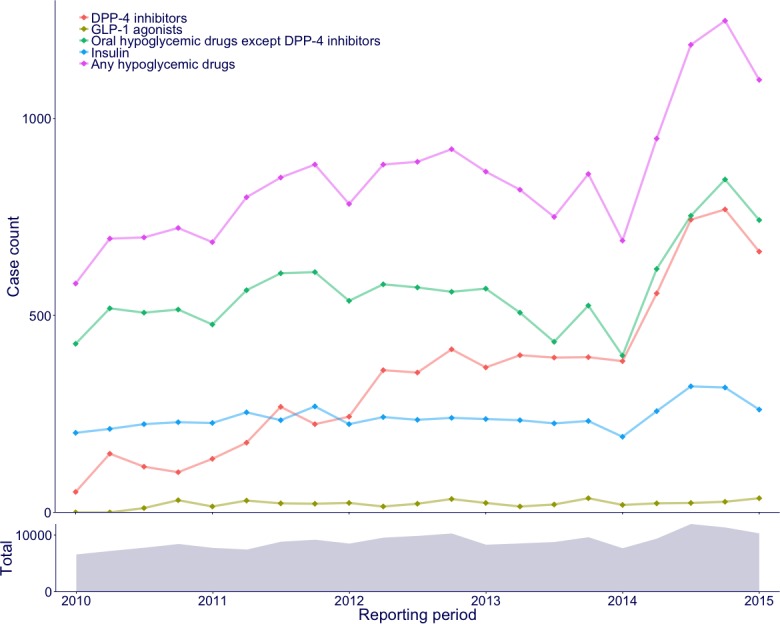
Case counts of hypoglycemic drugs by each quarterly period.The line plot denotes cases reported with hypoglycemic drugs. The area plot denotes all cases.